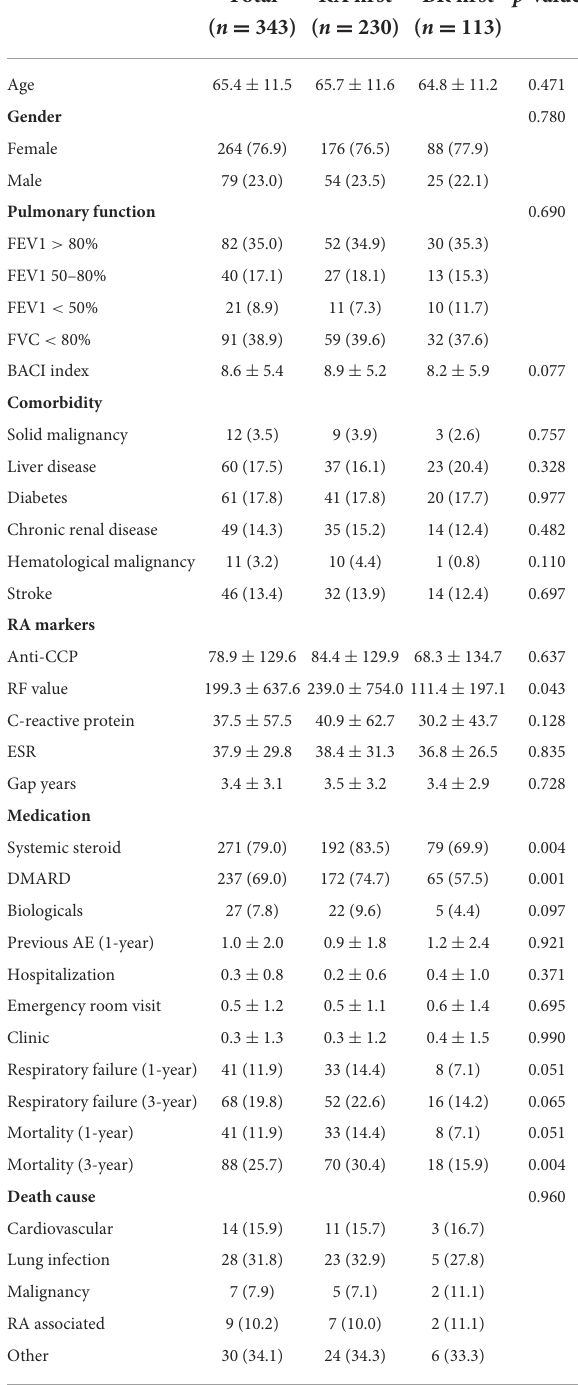
TABLE 2 Sputum microbiology of BROS with or without severe exacerbation during 3 years follow-up. General